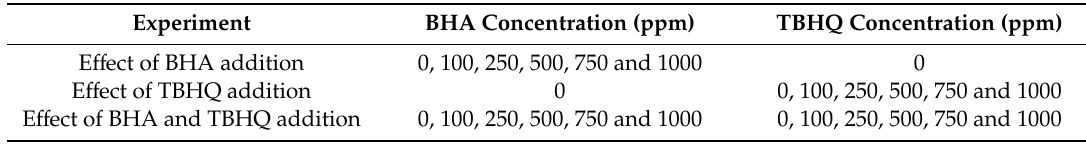
Table 2. Antioxidant addition to sa ffl ower biodiesel.